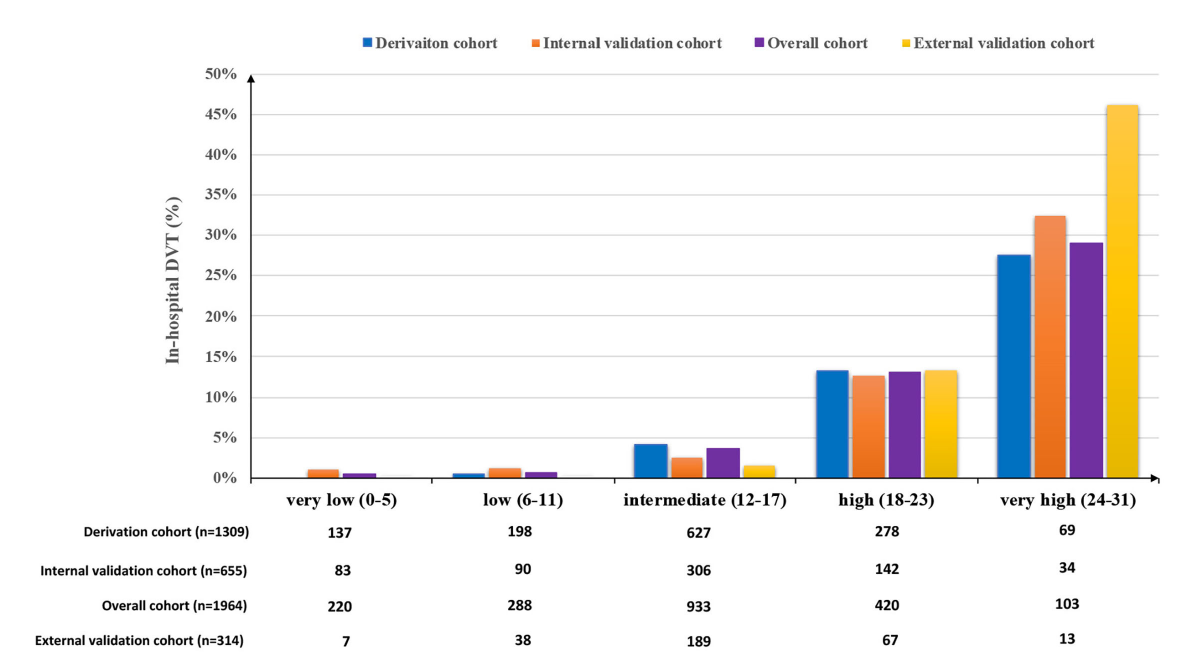
FIGURE2 Proportion of in-hospital DVT after ICH according to the ICH-DVT score in the derivation, internal validation, and external validation cohorts. The risk categories were assigned in six-point increments. The potential risk of in-hospital DVT after ICH increased steadily with a higher ICH-DVT